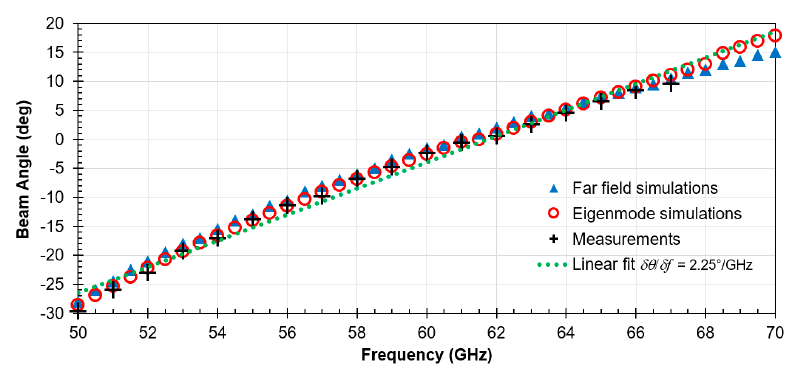
Figure 8. H Beam steering behavior of the SIW LWA as beam angle over frequency from far field simulations (triangles, blue), Eigenmode simulations (circles, red), measurement results (crosses, black), and their linear fit (green).